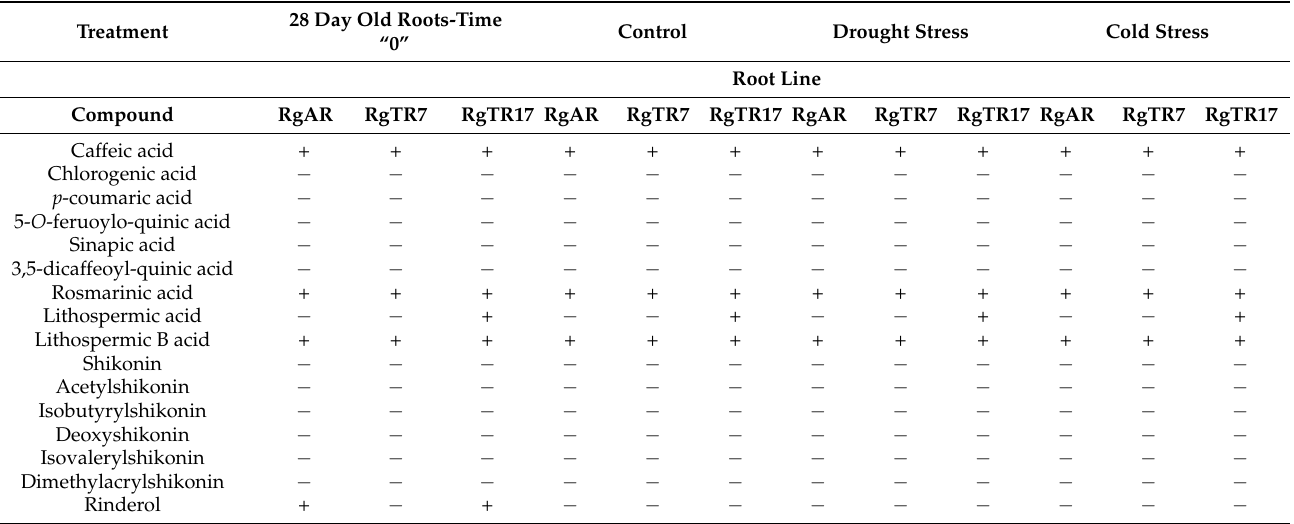
RgAR—anatomical roots; RgTR7—hairy root line TR7; RgTR17—hairy root line TR17; time “0”—28-day-old roots at time of inoculation; Control—roots cultivated without any treatment for 14 days; Drought stress—roots treated by drought stress for 14 days; Cold stress—roots treated by cold stress for 14